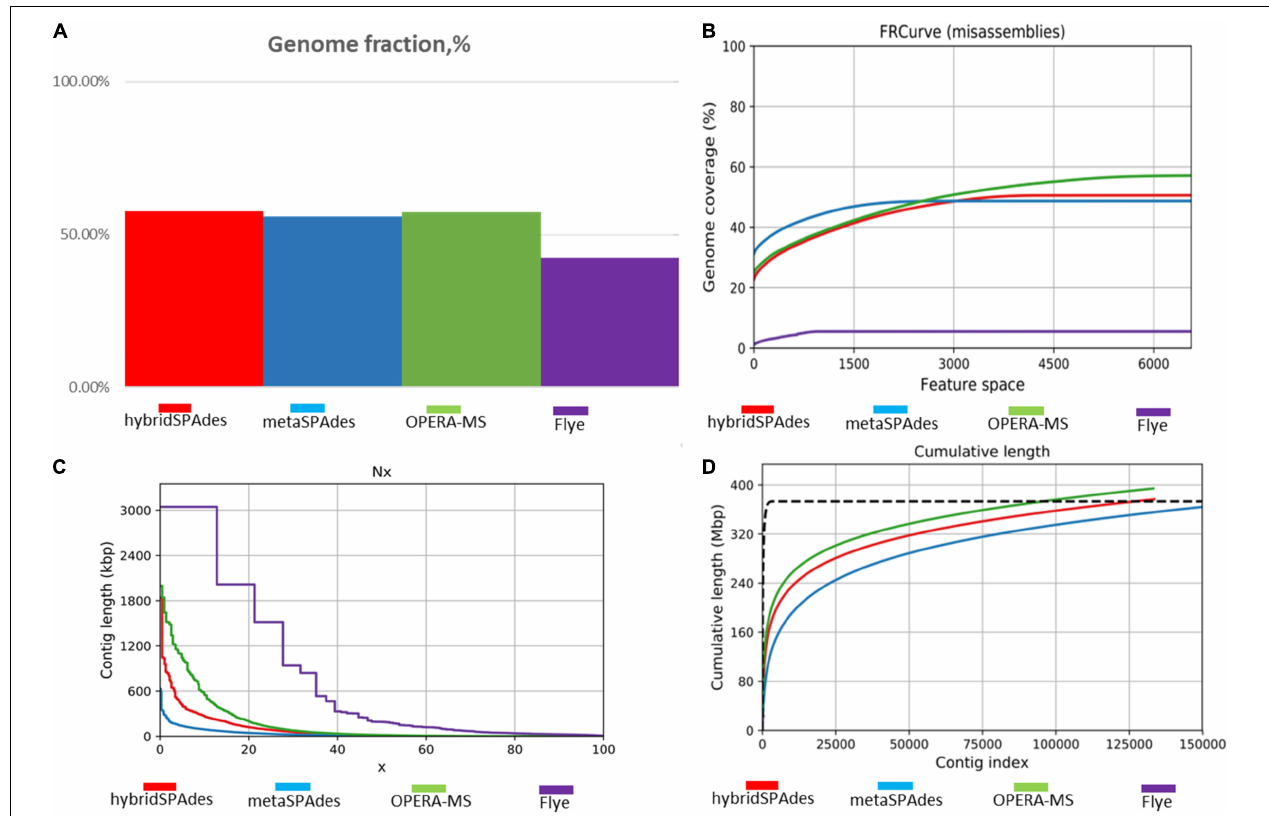
FIGURE 2 | Comparison of the healthy human gut metagenome assembly statistics from the four different assembly methods. (A) Genome fraction depicted by different methods. Genome fraction is the percentage of aligned bases in the reference genome. A base in the reference genome is aligned if there is at least one contig with at least one alignment to this base. Contigs from repetitive regions may map to multiple places, and thus may be counted multiple times. (B) Feature-response misassembly curve. Y is the total number of aligned bases divided by the reference length, in the contigs having the total number of misassemblies at most X . FRCurve definition: given any such set of features, the response (quality) of the assembler output is then analyzed as a function of the maximum number of possible errors (features) allowed in the contigs. (C) Percentage distribution ( X -axis) of contig length ( Y -axis) with the four methods. (D) Cumulative number of assembled nucleotides in contigs of different lengths. Each line corresponds to a different assembly program (hybridSPAdes, metaSPAdes, OPERA-MS, and